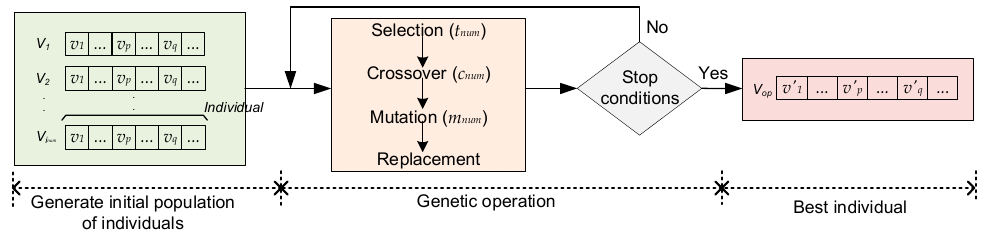
Figure 2. Flowchart of the GA.